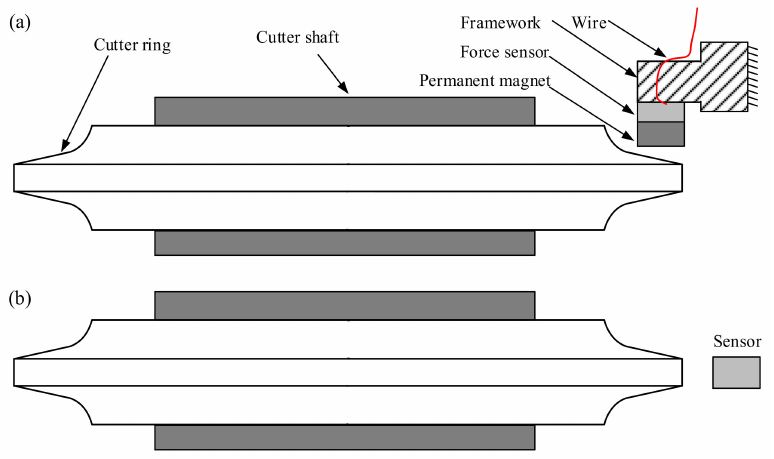
Figure 2. The architecture of the detecting system, ( a ) Architecture adopted in this work; ( b ) Archi- tecture commonly adopted in current